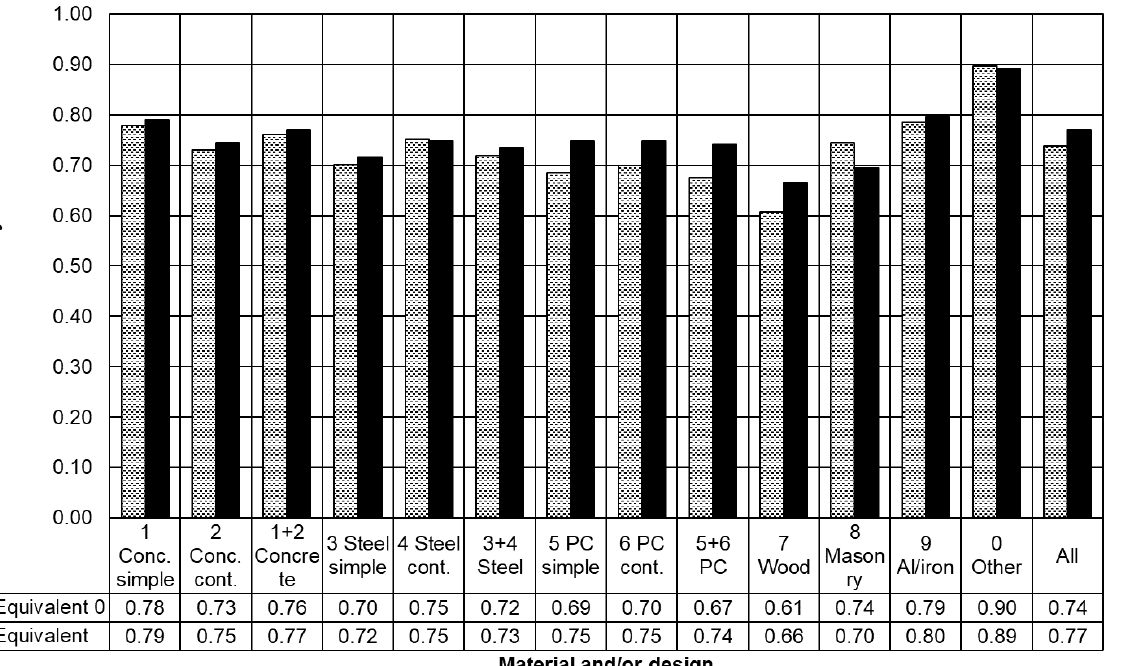
Figure 5. Comparison of structural performances of bridge areas without and with reconstruction data.